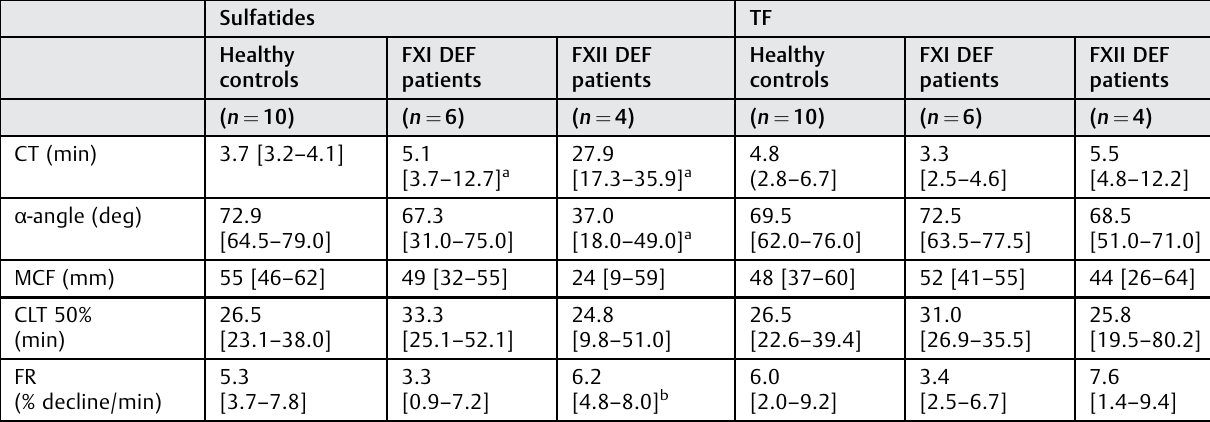
Table 3 ROTEM parameters — intrinsic and extrinsic pathway